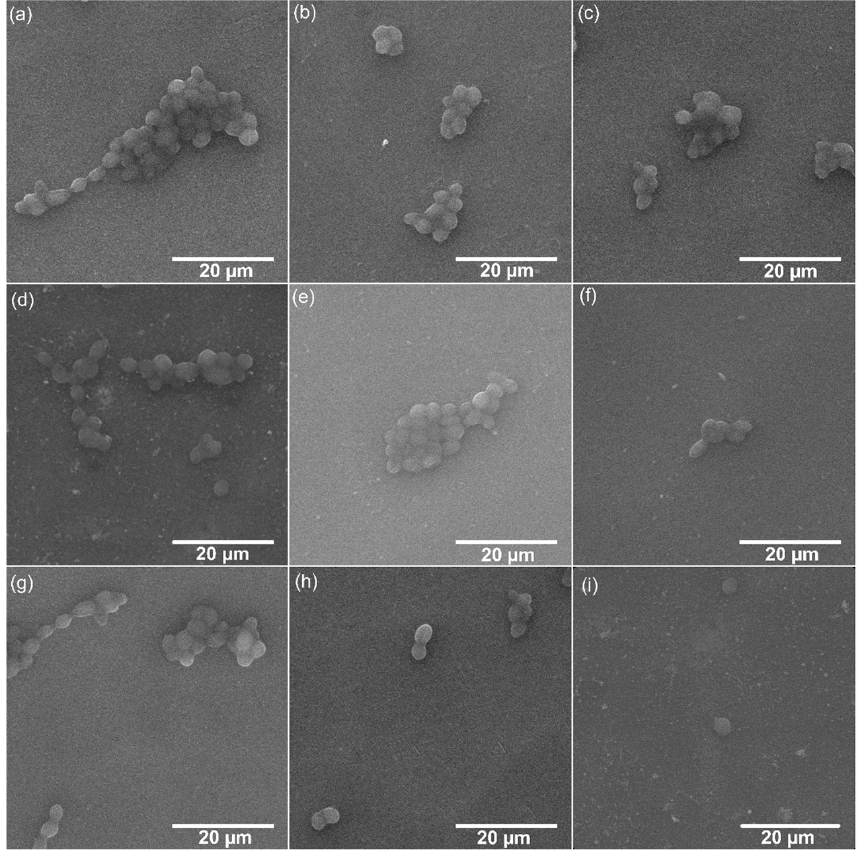
Figure 9. SEM images of Candida albicans ATCC 10231 cell development on the surface of CS-HAp_1 ( a – c ), CS-HAp_2 ( d – f ), and CS-HAp_3 ( g – i ) after 24 h ( a , d , g ), 48 h ( b , e , h ), and 72 h ( c , f , i ) of incubation.